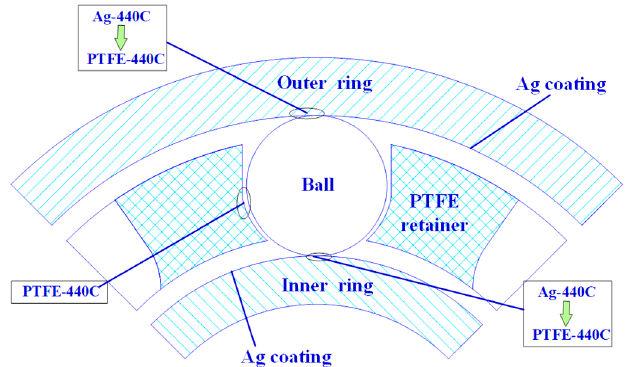
Figure 1. The lubrication states of bearing contact surfaces in the different working stages.